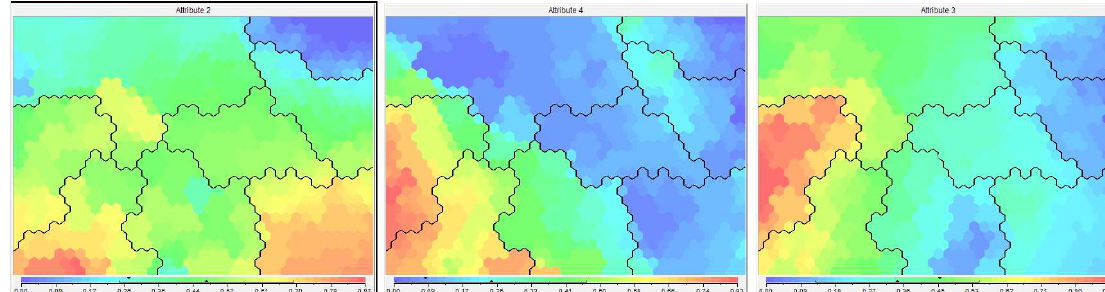
Figure 1. Kohonen maps obtained